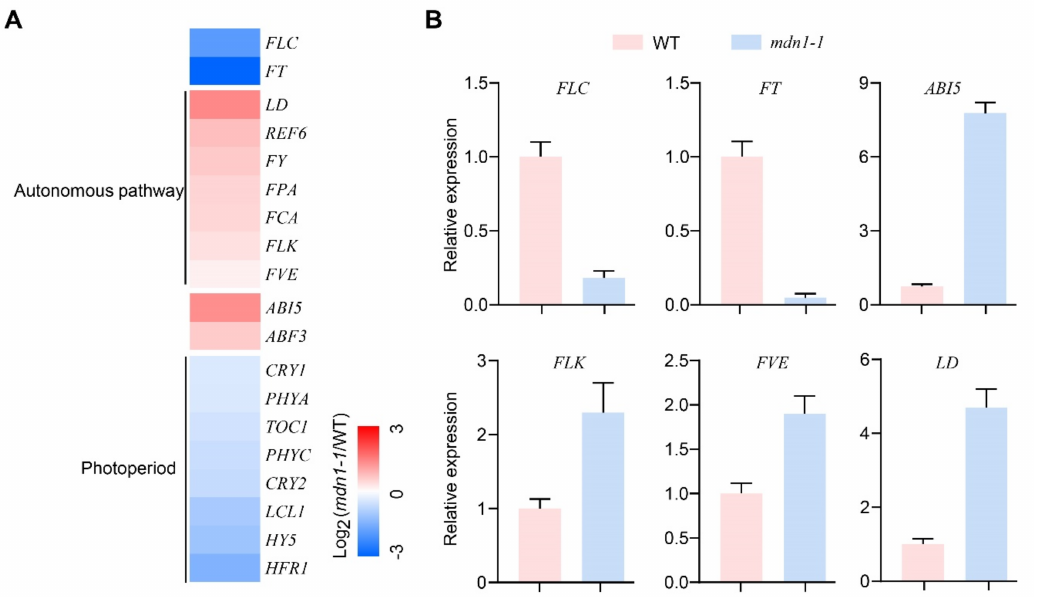
Figure 2. Gene expression profiling of WT and mdn1-1 seedlings. ( A ) The expression analysis of genes involved in flowering time regulation uses the log 2 -transformed fold-change values. Red, blue, and white indicate an increase, decrease, and no difference in expression levels, respectively. ( B ) Quantitative RT-PCR (qRT-PCR) results showing the expression of the indicated genes in the WT and mdn1-1